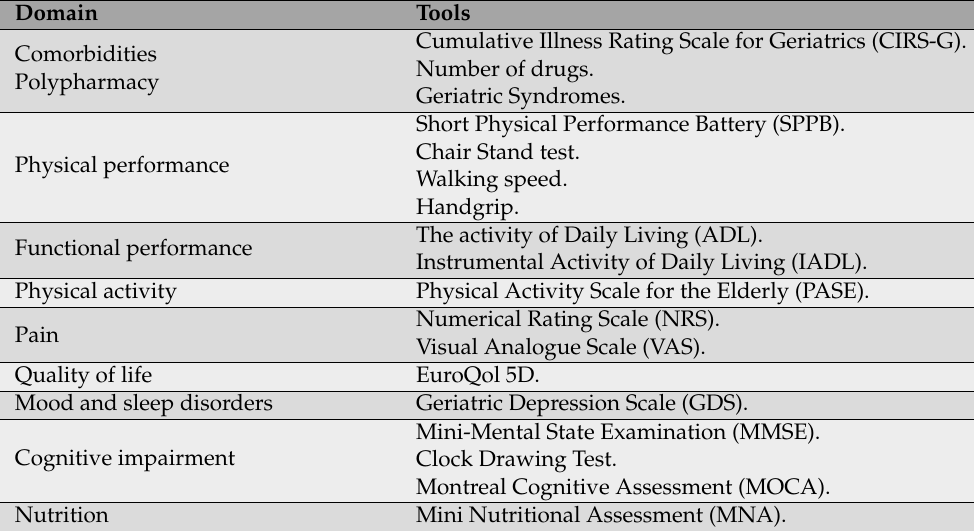
Table 2. The comprehensive geriatric assessment used in our center.